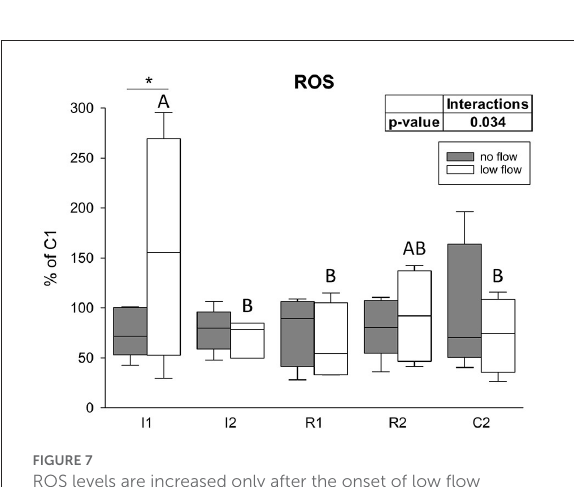
FIGURE7 ROS levels are increased only after the onset of low flow ischemia in equine intestinal epithelium. Values are given relative to C1 ( = 100%, gray line). Asterisks indicate significant differences between the two groups at identical time points and different letters indicate significant differences between the time points in the low flow group exclusively (* p < 0.05, two-way RM ANOVA with post-hoc Holm-Sidak test). Boxes and error bars show the median, 10th, 25th, 75th, and 90th percentiles (no flow: gray; low flow: white); N = 5 (no flow) or N = 4 (low